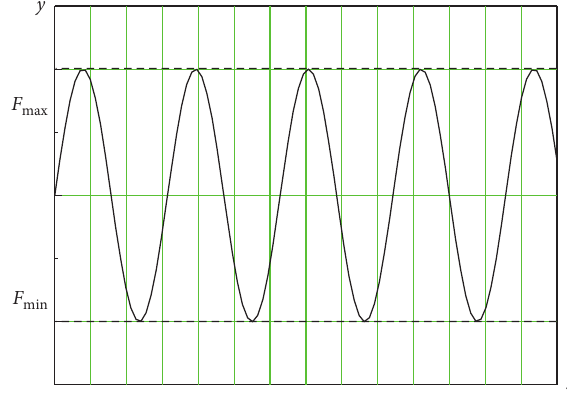
Figure 4: Schematic of the loading waveform.